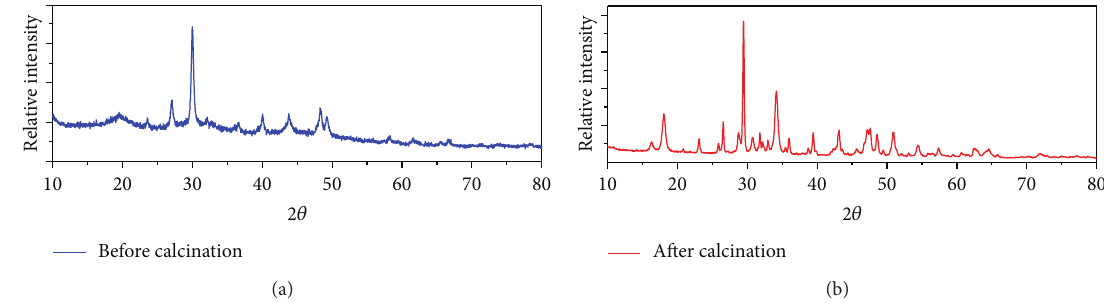
Figure 1: Diffractogram of crab shell; (a) before calcinations and (b) after calcinations at temperature 1000 ∘ C for 5 hours.